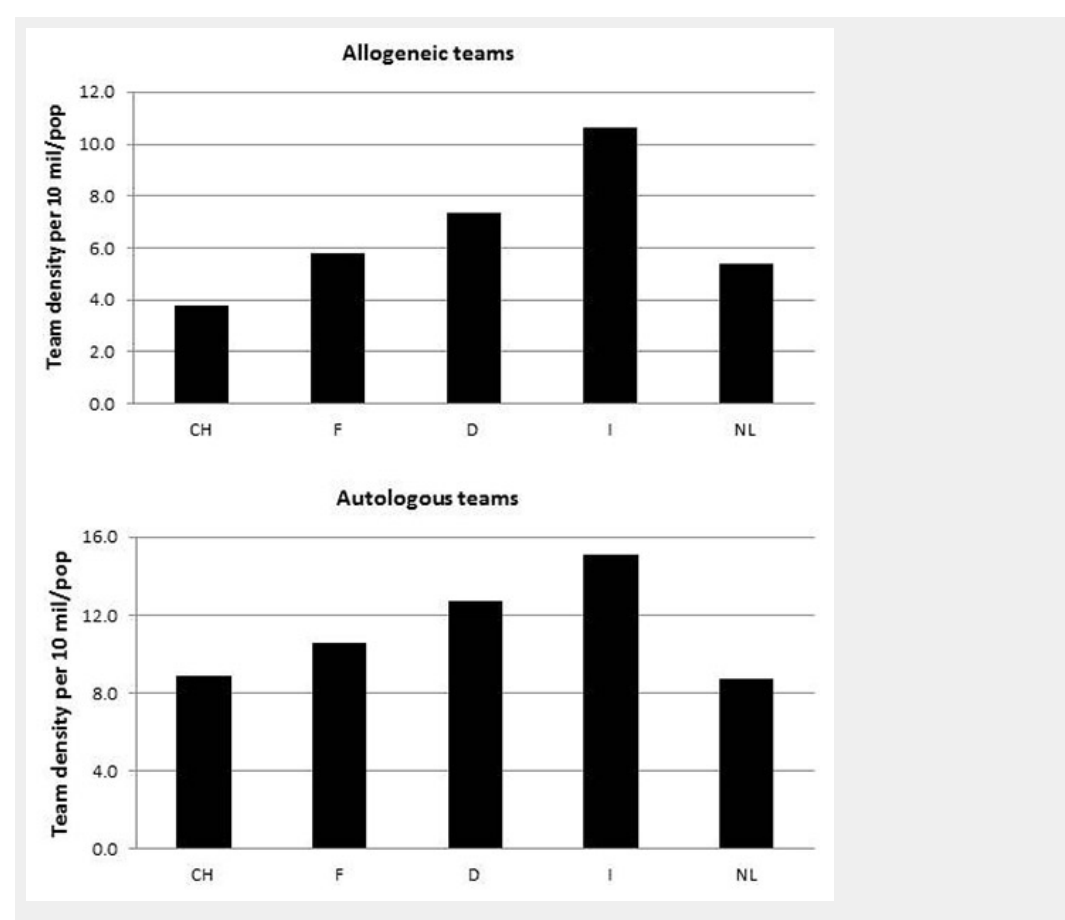
Figure 6 Transplant team density (number of teams per 10 million inhabitants). 6a: allogeneic HSCT. 6b: autologous HSCT (CH: Switzerland, F: France, D: Germany, I: Italy, NL: the